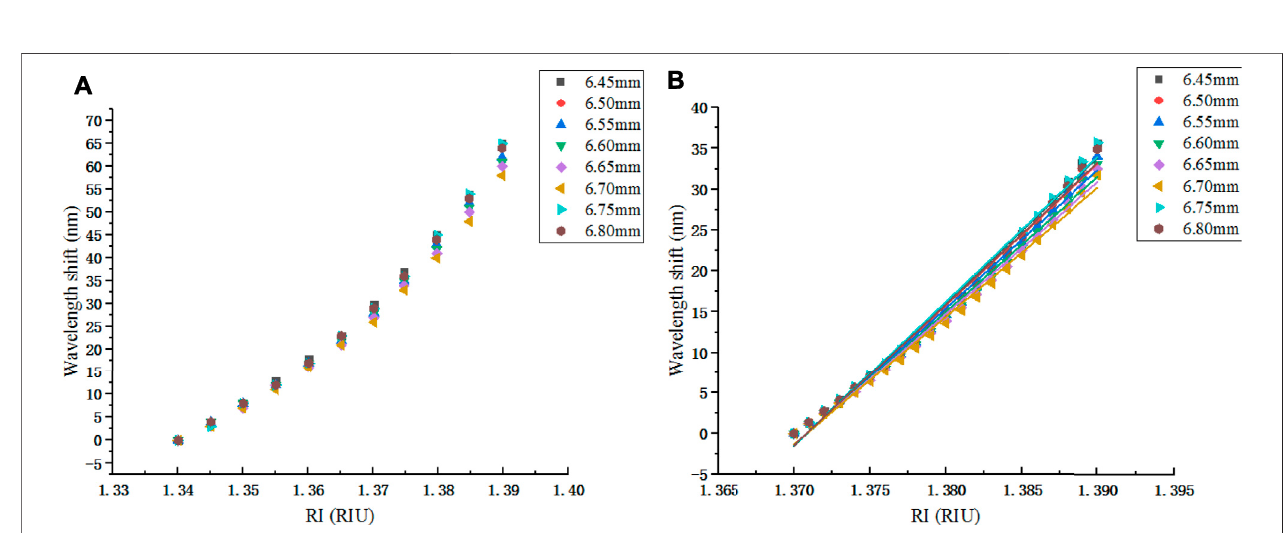
FIGURE 11 | RI sensitivity of L variation at 1,500 – 1,650 nm when D 2 (cid:2) 20 μ m: (A) wavelength shift; (B) linear fi tting.